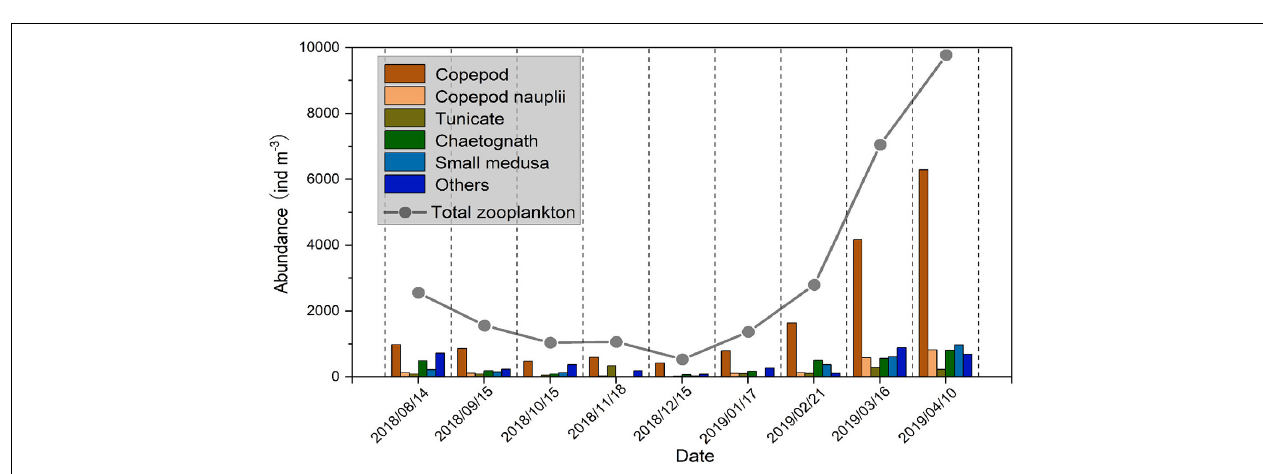
FIGURE 3 | Zooplankton abundance (ind m − 3 ) collected by a II plankton net at the Station in Jiaozhou Bay from August 2018 to April 2019.